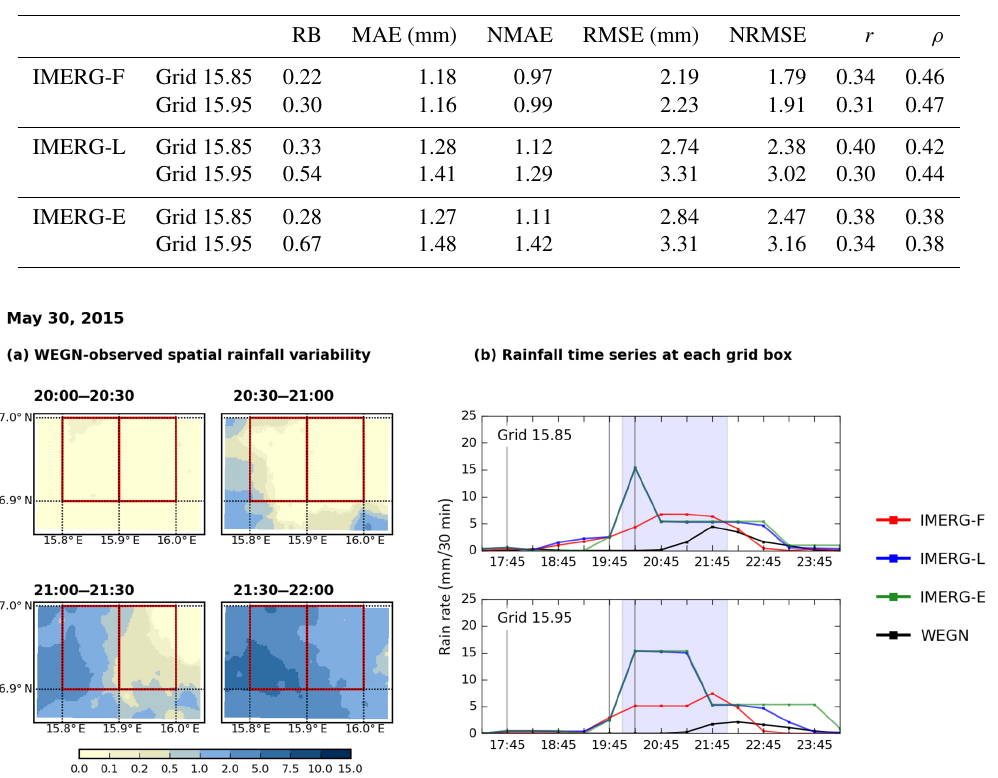
Table 2. Validation statistics comparing the performance of IMERG runs at each grid box.